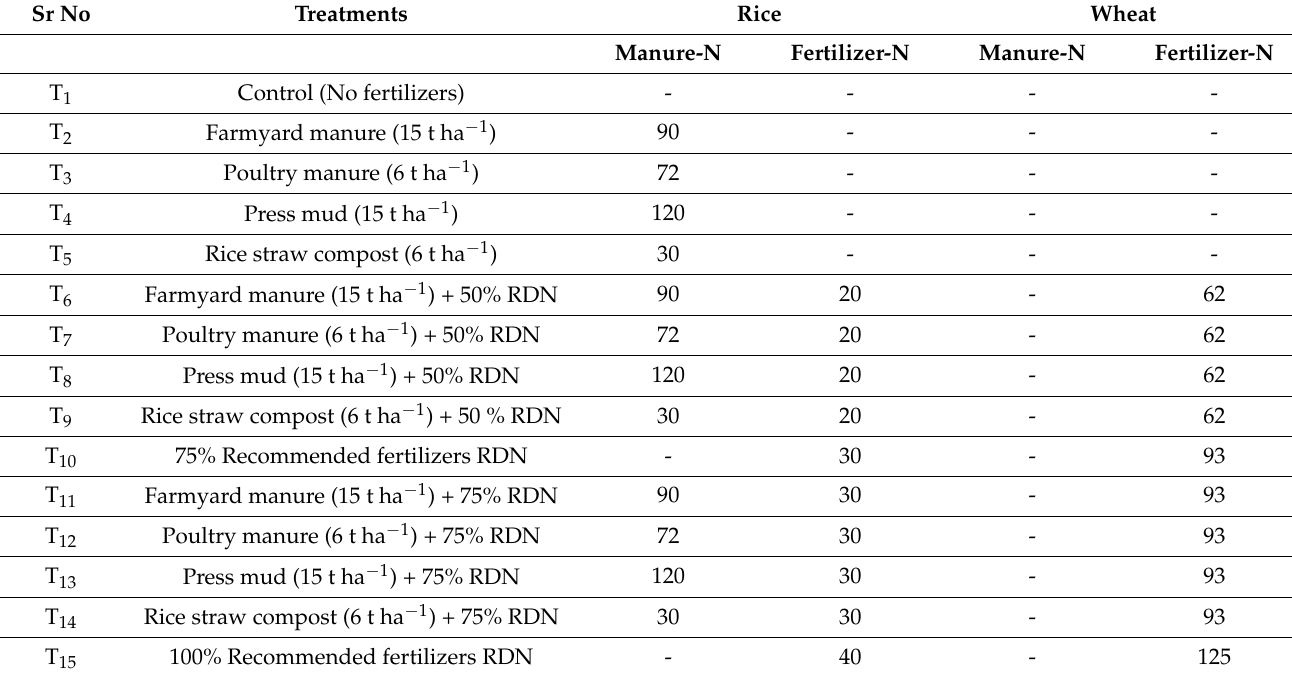
Table 1. Treatment details along with the N added in each treatment through manures and